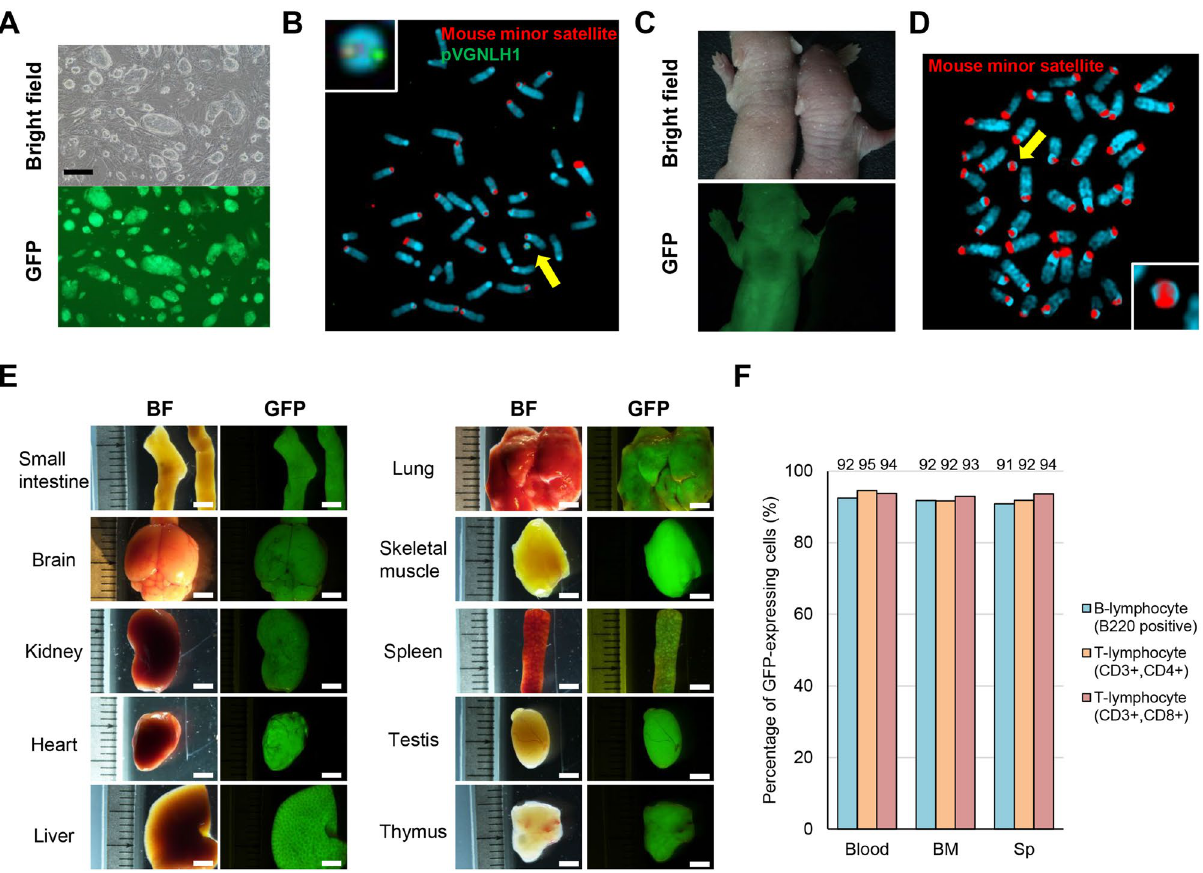
Figure 6. Generation of Tc mice carrying 10MAC1 and its stability in the tissues. (A) Phase-contrast (top panel) and fluorescence (bottom panel) micrographs of mouse ES hybrids carrying 10MAC1 are shown. Scale Bar: 100 μm. (B) FISH analysis of the mouse ES hybrids carrying 10MAC1 using the digoxigenin-labeled mouse minor satellite DNA (red) and the biotin-labeled pVGNLH1 (green). Inset shows an enlarged image of the 10MAC1. (C) Phase-contrast (top panel) and fluorescence (bottom panel) micrographs of wild-type (right) and Tc mice (left) are shown. (D) Representative FISH image of metaphase chromosome spreads of lymphocytes in blood from Tc mice using the digoxigenin-labeled mouse minor satellite DNA (red). Inset shows an enlarged image of the 10MAC1. (E) GFP images of different tissues from Tc mice carrying the 10MAC1. GFP expression indicates the presence of 10MAC1. Exposure times for each GFP image of small intestine, brain, kidney, heart, liver, lung, skeletal muscle, spleen, testis, and thymus were 100, 500, 200, 100, 400, 700, 100, 400, 200 and 200 ms, respectively. Scale bar: 3 mm. (F) Percentage of GFP-expressing lymphocyte subsets from blood, bone marrow and